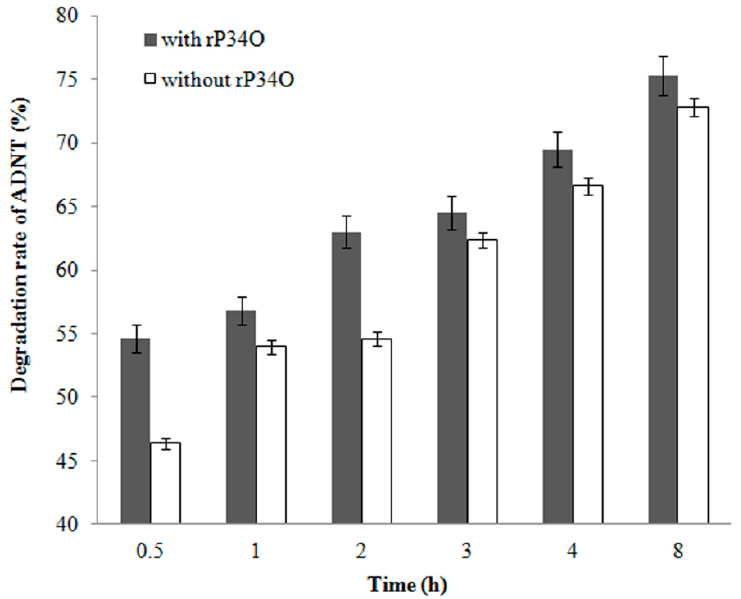
Figure 7. Percentage degradation rates of ADNT by Buttiauxella sp. S19-1 over time. Buttiauxella sp. S19-1 cultures were exposed to 20 µ L of 0.1 mg/mL ADNT and incubated for 2 h. rP34O was then added to cultures, and degradation rates were determined at the various time points (gray). S19-1 cultures without additional rP34O were treated as negative control (white). Values are presented as mean of N = 4, x ± SD. Statistical significance is denoted as p < 0.05 using SPSS.